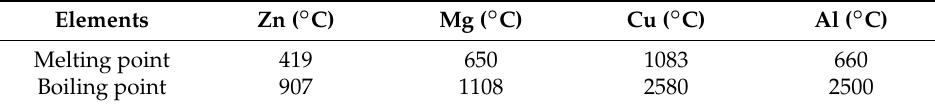
Table 2. Melting point and boiling point of the elements.